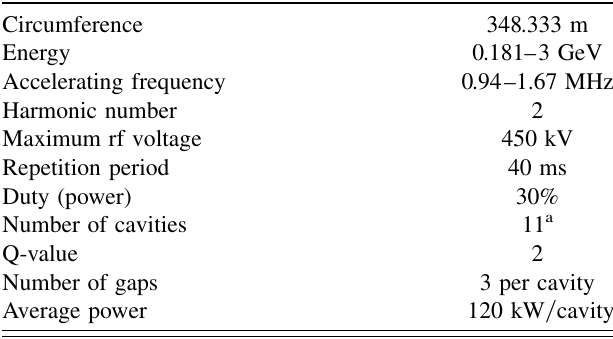
TABLE I. Parameters of the J-PARC RCS